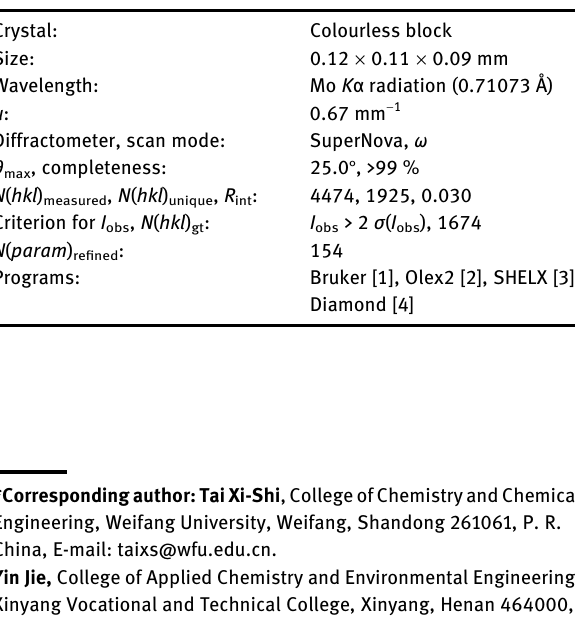
Table  : Data collection and handling.